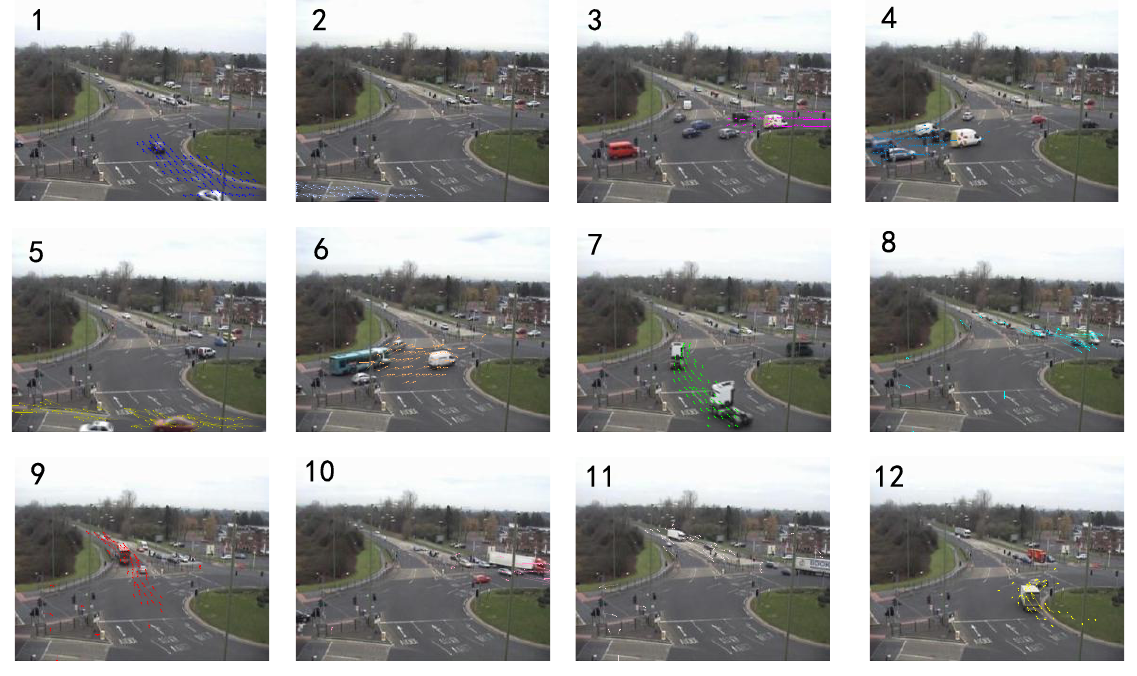
Figure 7. The experimental results on the roundabout dataset. ( a ) Top: illustration of the top 12 topics; ( b ) Bottom: the timelines of the 12